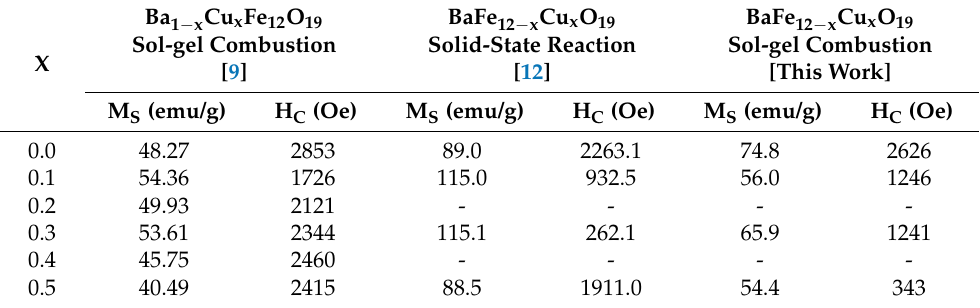
Table 2. Comparison of saturation magnetization (Ms) and coercivity (Hc) from the present work to those reported by Asiri et al. [9] and Rafiq et al.